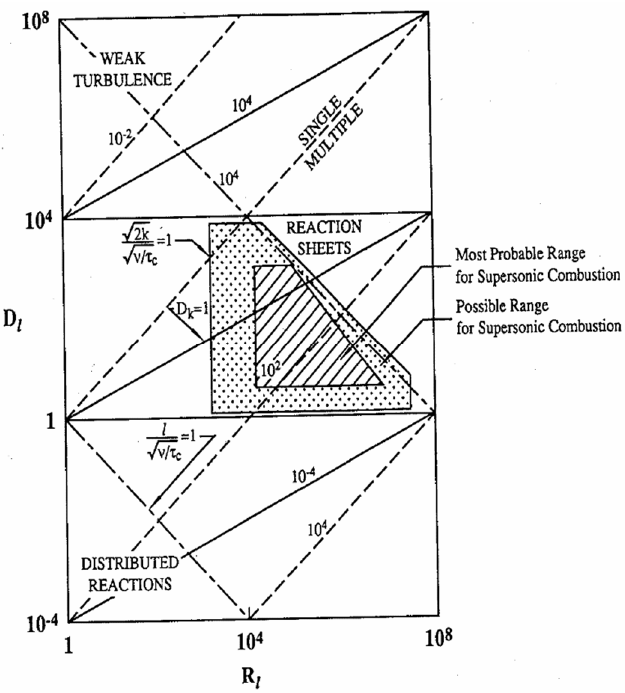
Figure 4. Borghi diagram.